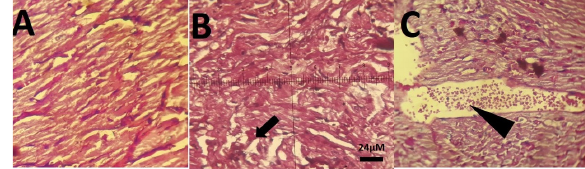
Figure 4. Light Micrographs of Heart Sections; A: control rats. B: lead-treated rat; arrow shows hypertrophy of heart muscles (Arrow). C: heart section of a CeNPs-treated lead-intoxicated rat; arrow shows congestion (arrow point) (H & E staining microscopic magnification ×